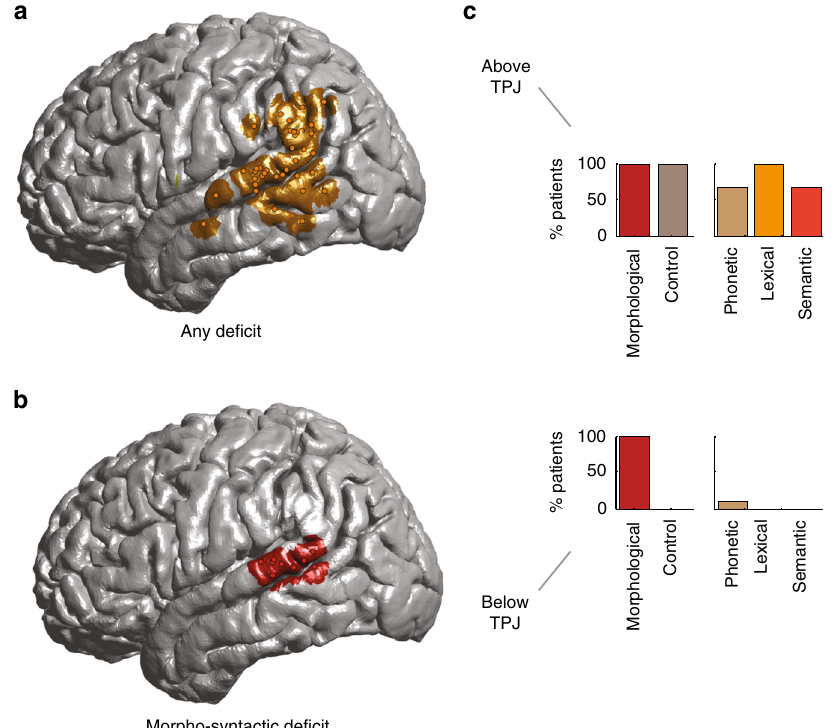
Fig. 2 Stimulation of focal sites transiently inhibits functional morpheme production. Individual stimulation sites are de fi ned based on their selectivity and anatomic location. Here, the stimulation sites were evaluated across all the participants. a Stimulation sites that produced a non-selective linguistic de fi cit during production. b Stimulation sites that produced a de fi cit during the syntactic condition only. c The bar graphs represent the percentage of patients stimulated in the stated region in which stimulation elicited a de fi cit (out of those that produced any signi fi cant de fi cit) above and below the TPJ (see Fig. 3, below, for further details and Supplementary Figure